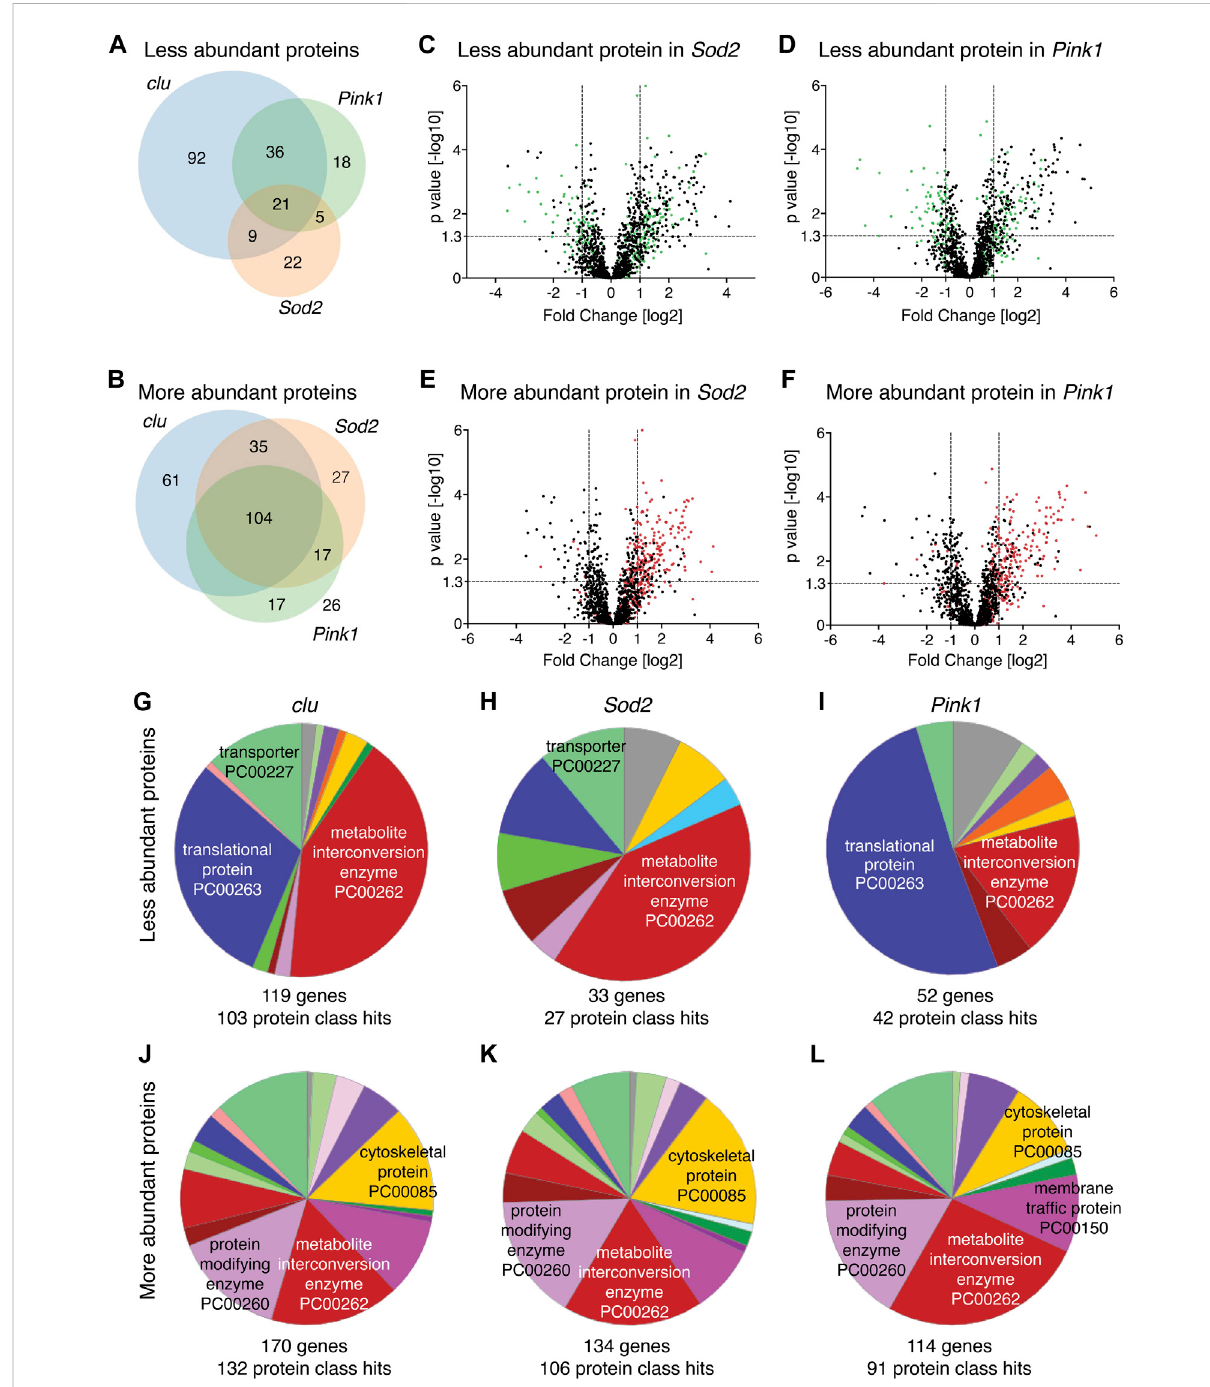
FIGURE 2 (A,B) Venn diagrams comparing the numbers of less abundant (A) and more abundant (B) proteins in clu , Sod2 and Pink1 mutants. (C – F) Volcano plots showing the distribution of proteins that were either less abundant (green dots) and more abundant (red dots) in clu mutants superimposed on Sod2 (C,E) and Pink1 (D,F) volcano plots. p values ( − log10) and Fold Change (log2) were plotted on the y -axis and x -axis, respectively. The vertical dotted lines mark the cut-off limits for Fold Change [log2] > 1 and the horizontal dotted line denotes the p value [ − log10]=1.3. (G – L) Piecharts showingPANTHERProteinClass(PC)ontologyoflessabundantproteins (G – I) andmoreabundant proteins (J – L) for clu , Sod2 ,and Pink1 mutants.Numbers ofgenesandproteinclasshitsarebeloweach piechart.Majorproteinclass hitsineach mutantweremarked on pie chart slices. Names of all protein classes along with color codes and respective percent hits are in Supplementary Table